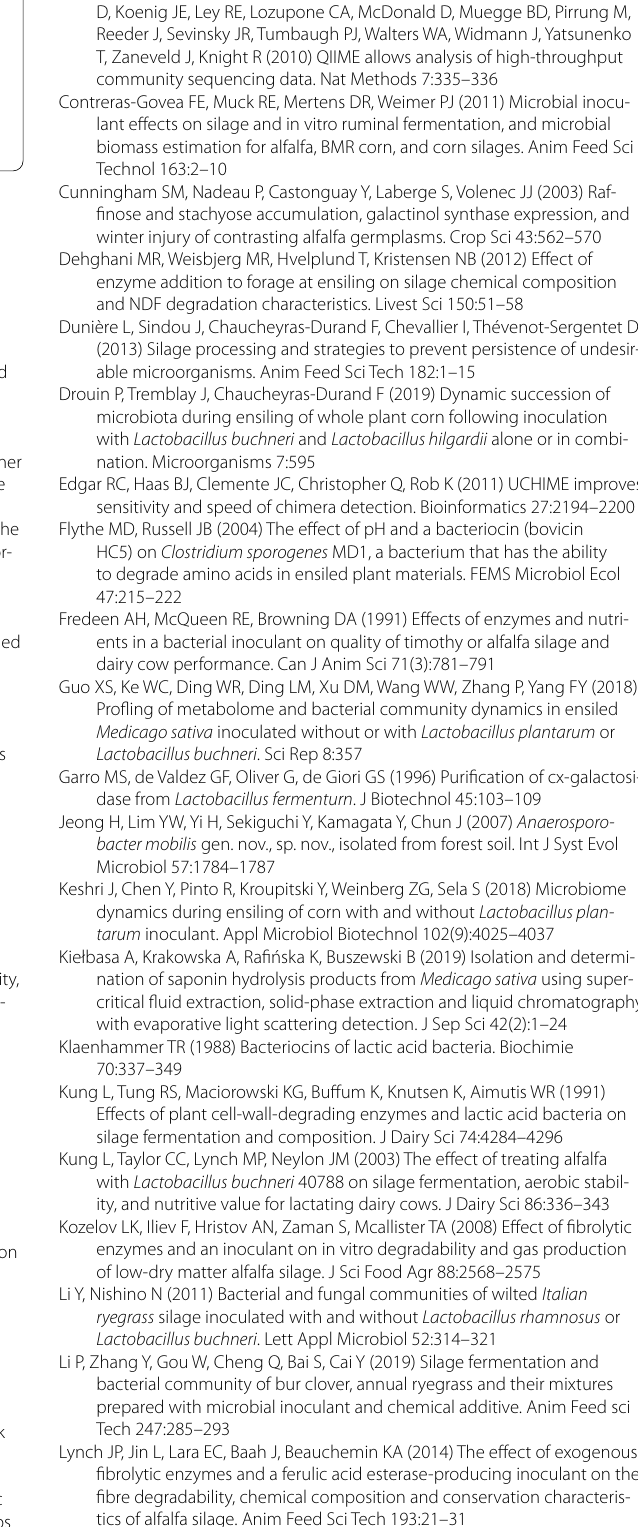
Additional file 5: Figure S5. Community barplot analysis showing bacterial composition of the alfalfa silage at OUT level. CON untreated silage, CEGA silages treated with cellulase plus α-galactosidase, CELP silages treated with cellulase plus L. plantarum , GALP silages treated with α-galactosidase plus L. plantarum